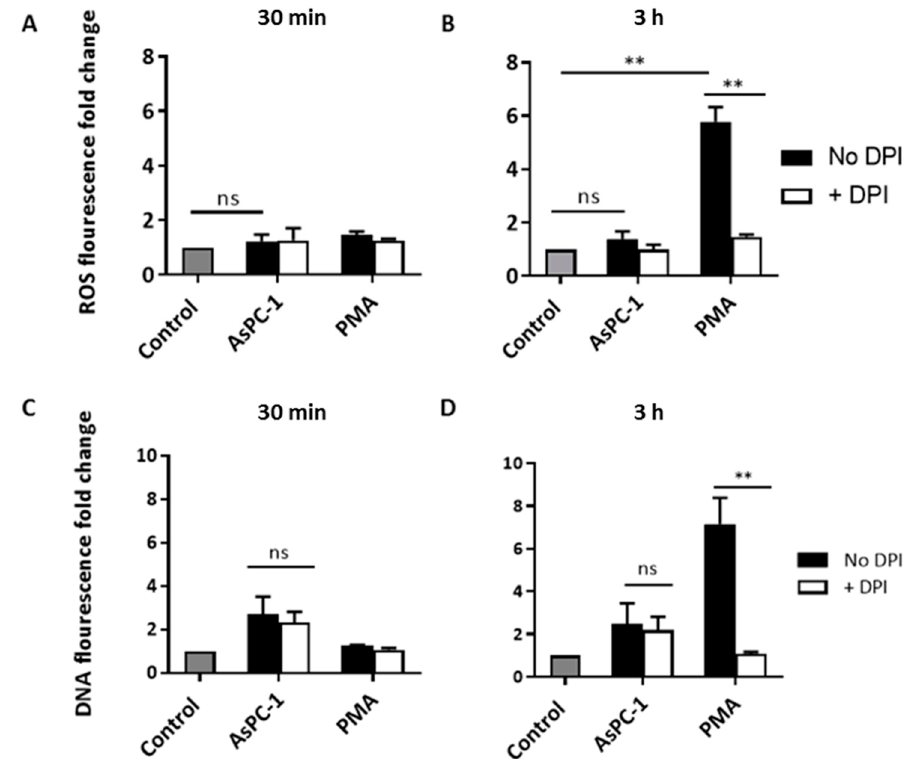
Figure 4. AsPC-1-induced-NET generation is independent of reactive oxygen species production. ( A , B ) Quantification of reactive oxygen species (ROS) generated during incubation with AsPC-1 CM and PMA at ( A ) 30 min and ( B ) 3 h using 2 ′ ,7 ′ -dichlorodihydrofluorescein diacetate (H2DCFDA) fluorescent dye. ROS were not significantly generated in AsPC-1 CM-stimulated neutrophils at either time points; ( B ) PMA-stimulated neutrophils had significant ROS generated at 3 h, this was abolished with the addition of non-specific ROS inhibitor diphenyleneiodonium (DPI); ( C , D ) The effect of DPI on NET release in AsPC-1 or PMA-induced NETs; ( C ) DPI did not reduce AsPC-1-induced NETs; ( D ) NETs were significantly reduced in PMA-stimulated neutrophils by DPI. n = 3, ** p < 0.001, ns = non-significant. One-way ANOVA followed by Bonferroni post-test. Data presented as mean ±